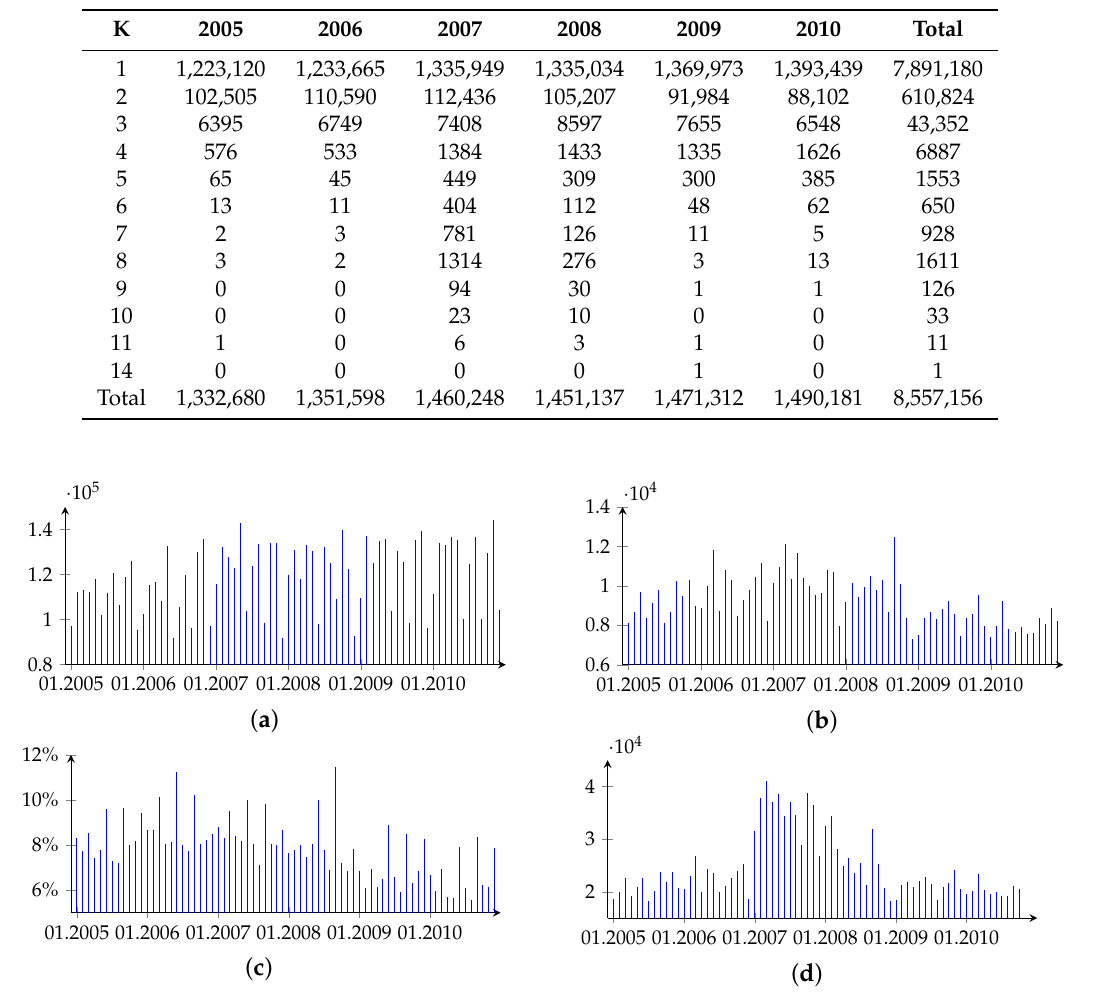
Figure 1. Monthly dynamics of ( a ) the amount of news; ( b ) the amount of news with co-mentions; ( c ) the share of news items with co-mentions; ( d ) the amount of co-mentions, from January 2005 to December